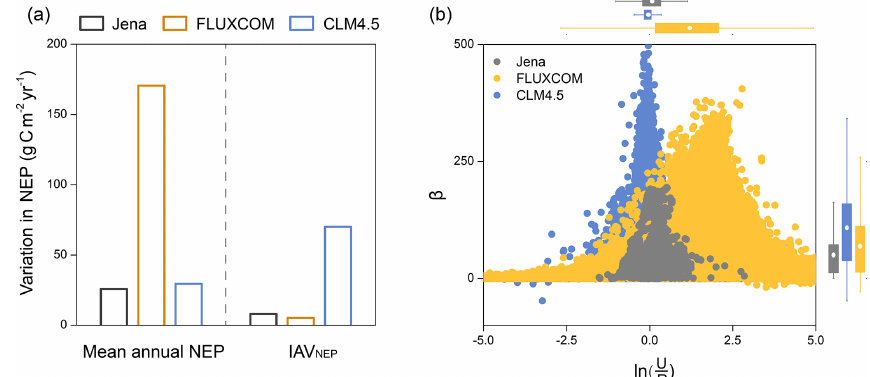
) for each site is R